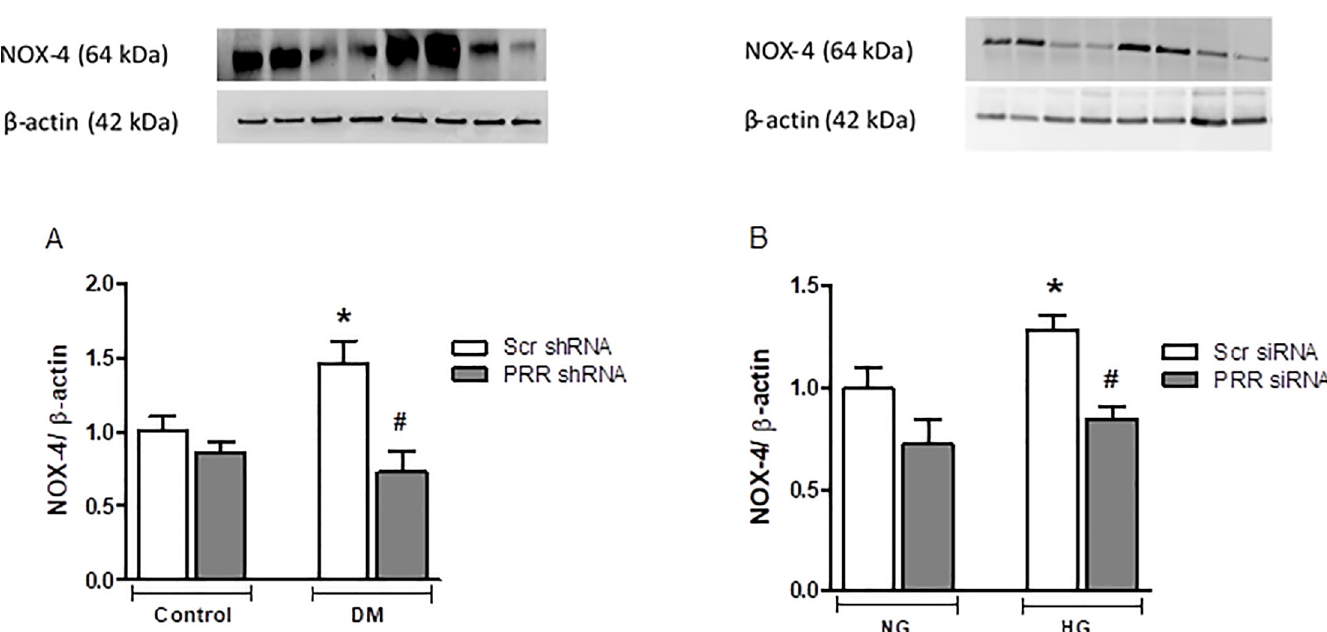
Fig 10. Expression of NOX4 in diabetic mice kidney and in mRMCs. Expression of NOX4 in (A) in renal cortex of normoglycemic control mice treated with scramble (Scr) shRNA (n = 5 each group), and streptozotocin (STZ)-induced diabetic mice (DM; n = 5 each group) treated with PRR shRNA (DM + PRR + shRNA; n = 5 each group), after eight weeks of STZ-induction of diabetes. Data are mean ± SEM. � P < 0.05 vs. Veh + Scr shRNA. #P < 0.05 vs. DM + PRR shRNA, (B) in normal glucose (NG, 25 mmol L-glucose) and high glucose (HG, 25 mmol D-glucose) cultured mRMCs treated with either scramble (Scr) siRNA or PRR siRNA. Data are mean ± SEM. � P < 0.05 vs. NG + Scr siRNA; #P < 0.05 vs. HG + PRR siRNA. n = 6 each